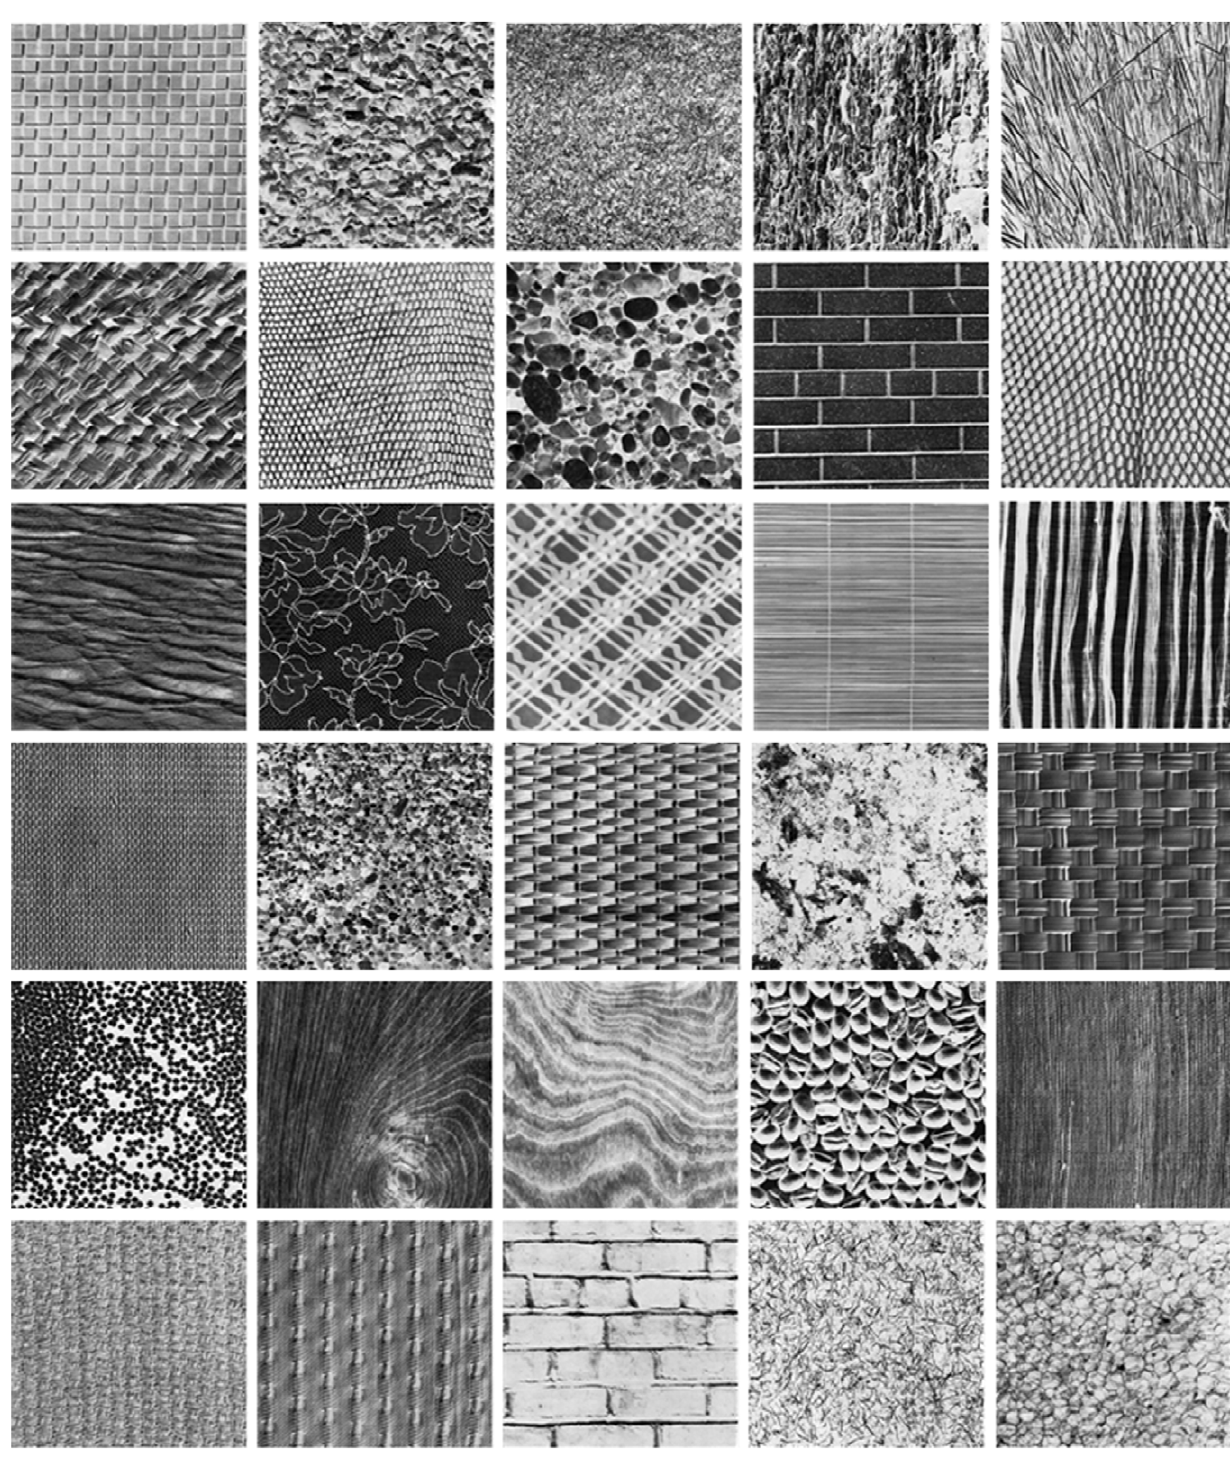
Figure 3. Different classes of texture images from the Brodatz texture database.